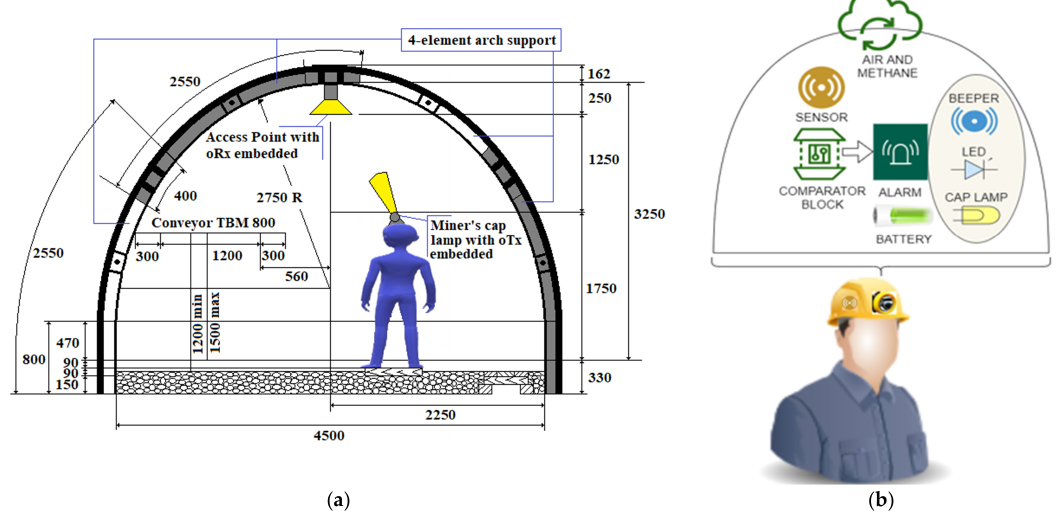
Figure 7. ( a ) The LoS topology between oTx as the miner’s cap lamp fixed on the helmet and the access point as oRx of the VLC setup and ( b ) The component blocks of the miner’s cap lamp, de-